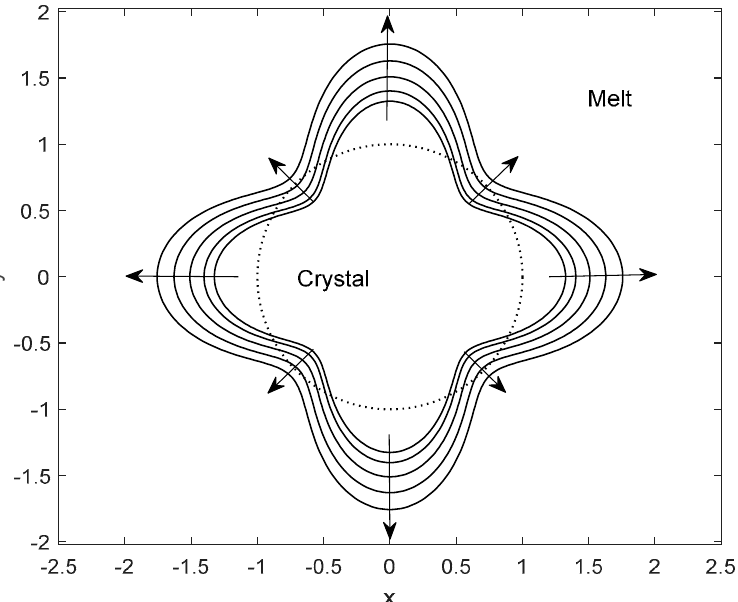
Figure 2. The cross-sectional curves of the interface morphology of the columnar crystal under the influence of anisotropic interface energy at different times t = 0.6,1.0,1.5,2.0,2.5, where α 4 = 0.25, r 0 = 1.1 R ∗ , Γ = 0.4545, and ∆ T = 10. By contrast, the dashed line denotes the columnar crystal without the anisotropic effect of interface energy. Arrows indicate crystal growth trends.